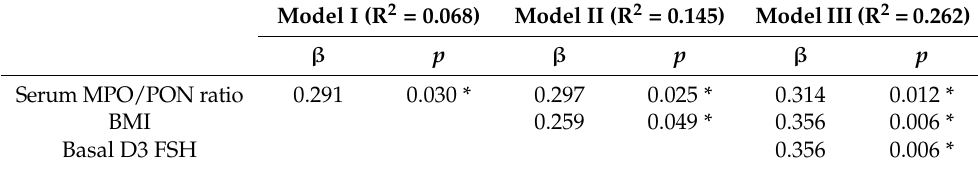
Table 4. Stepwise linear regression analysis for the duration of infertility.